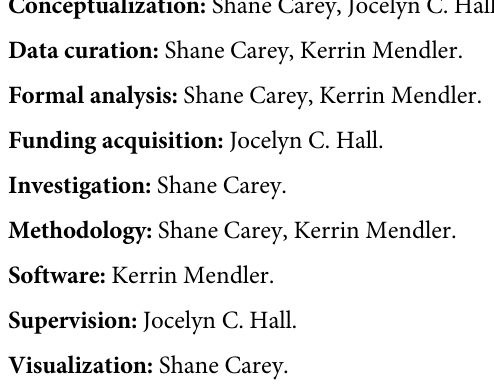
S1 Fig. Graph of top Gene Ontology (GO) terms for Erucaria erucarioides (blue) and Cakile lanceolata (white). Sample (n) and total (N) raw counts were log2 transformed for interspecies comparison. S1 Table. Benchmarking Universal Single Copy Ortholog (BUSCO) analysis of Erucaria erucarioides and Cakile